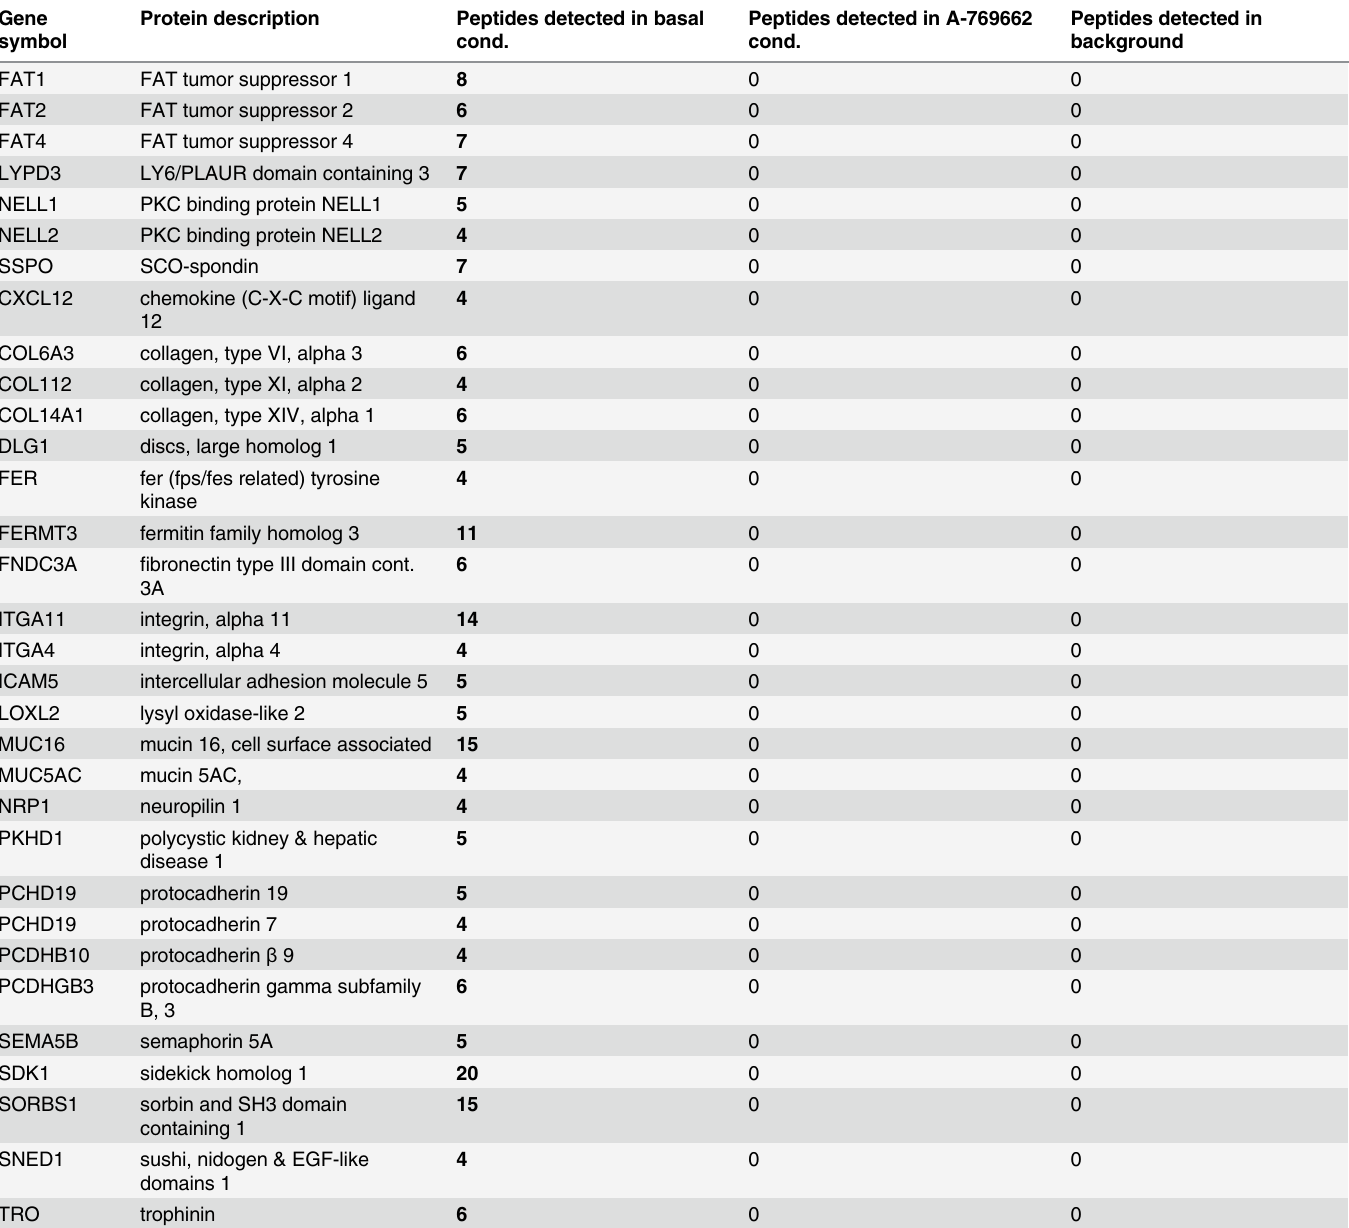
Shown are the 32 proteins with Cell Adhesion and Migration GO classi fi cation detected in the cell surface fraction of control but not A-769662 treated cells. Shown for each are the detected peptide counts in each of the treatment